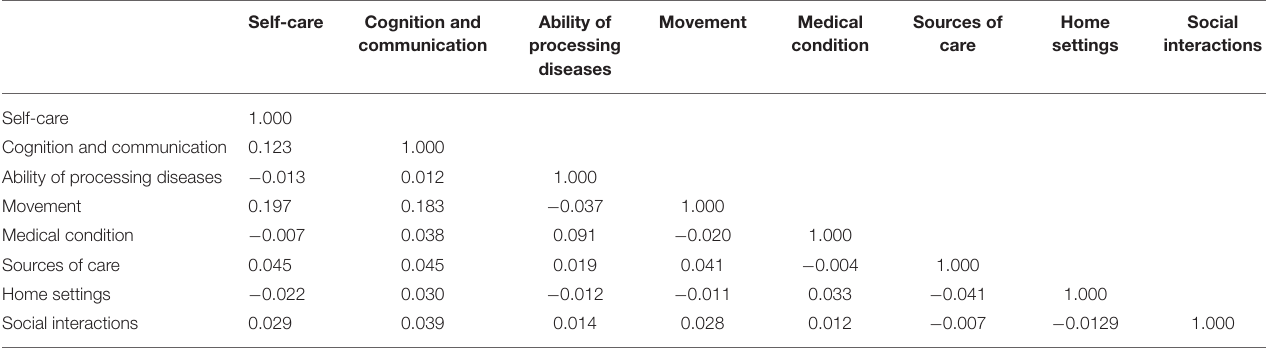
TABLE 10 | Residual matrix analysis of each dimension.